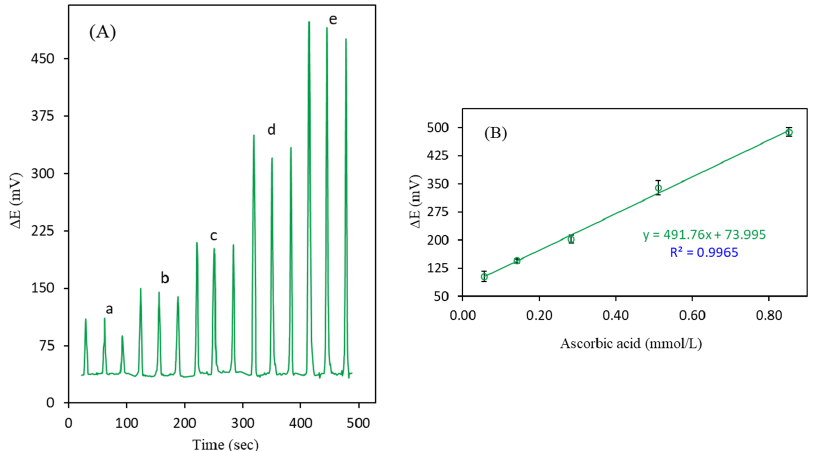
Figure 9. SIA-DEP potential peak intensity in triplicate of (a) 60.0, (b) 140.0, (c) 280.0, (d) 510.0, and (e) 850.0 µM of ascorbic acid at 20% bias of the Square wave ( A ) and calibration curve ( B ). Table 1. Analytical parameters for SIA-DEP determination of ascorbic acid at CNTs-Ag electrodes with comparison against reference standard iodimetric method. The number of measurements is 3.